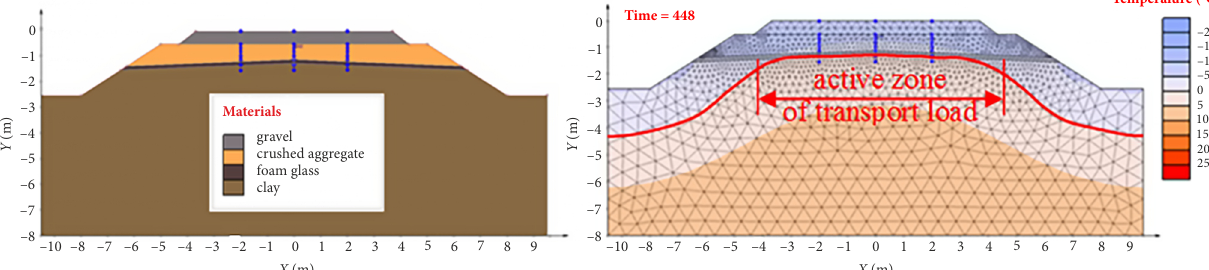
Figure 8. Numerical model No. 1: design of the body of the sub-ballast layers with built-in thermal insulation layer made of foam glass for the whole width of the embankment subgrade surface with respect to the applied climatic load I F = 1400 °C, day and θ m = 2 °C (left); the day of reaching the maximum freezing depth of the structural layers of the numerical model (right)